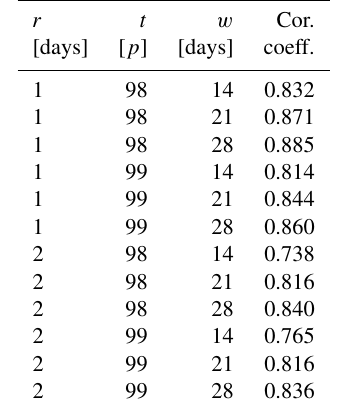
Table 3. Spearman rank correlation coefficients between S cl and ˆ φ for all parameter